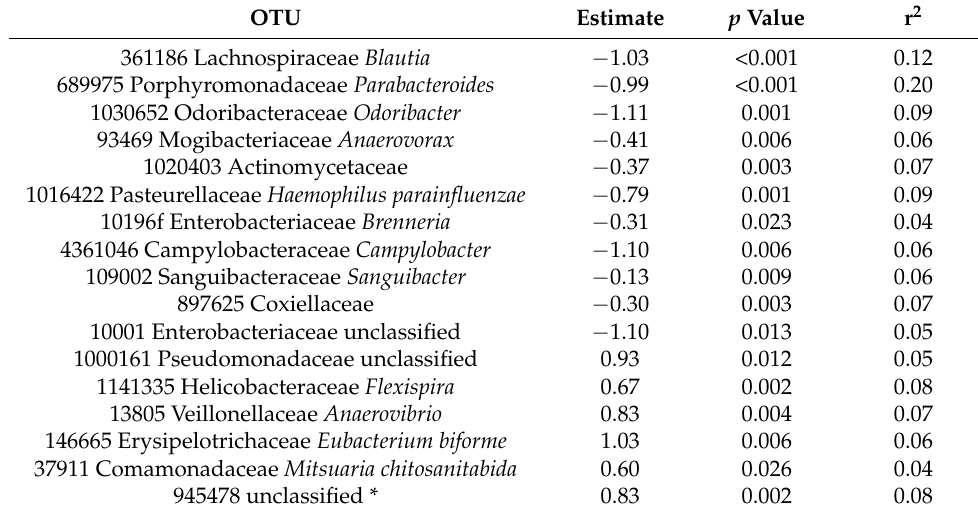
Table 8. Correlations between plasma levels of 4-ethylphenyl sulfate and OTUs.